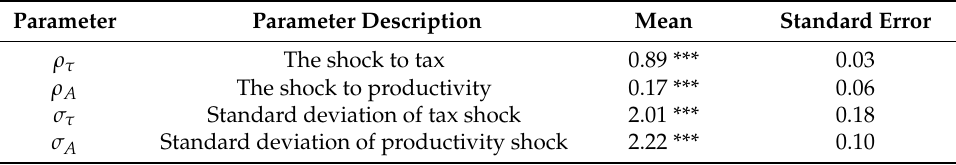
Table 2. Parametric estimates obtained from maximum likelihood estimation.